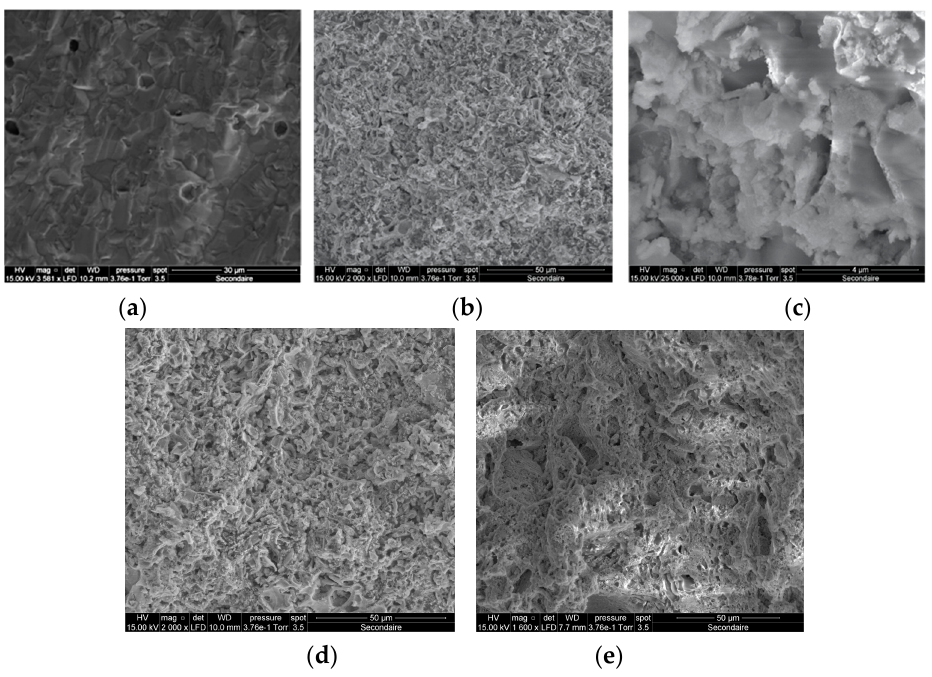
Figure 2. Representative SEM images of ( a ) BZY ( b , c ) BZY–LK, ( d ) BZY–LN, and ( e ) BZY–LKN composites.